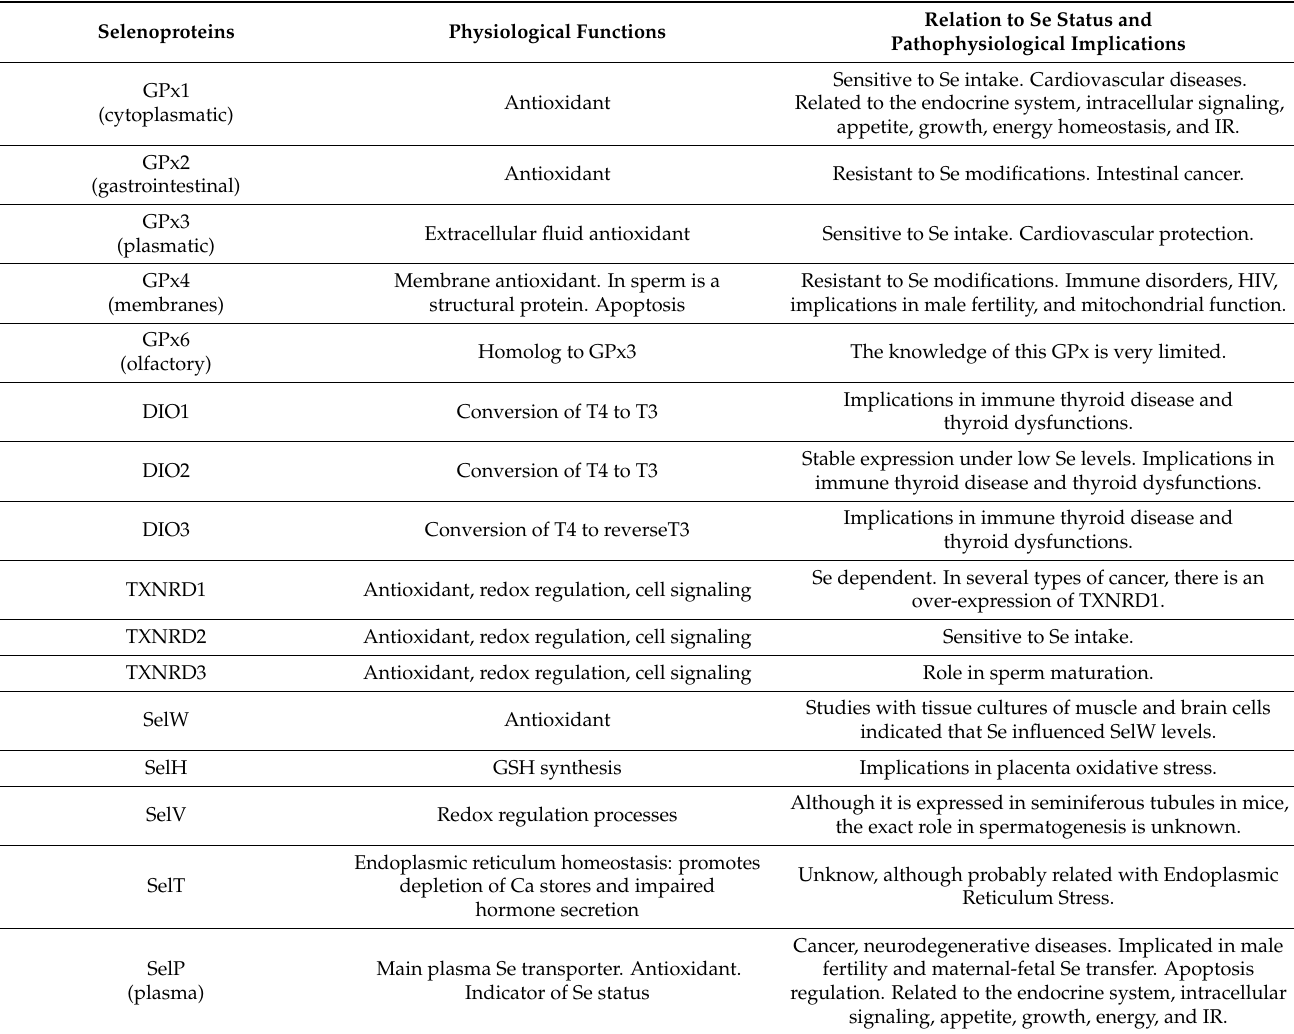
Table 1. Main selenoproteins, their physiological functions, relation to Se status, and pathophysiolog- ical implications (modified from Qazi et al. [39] and Hariharan et al.